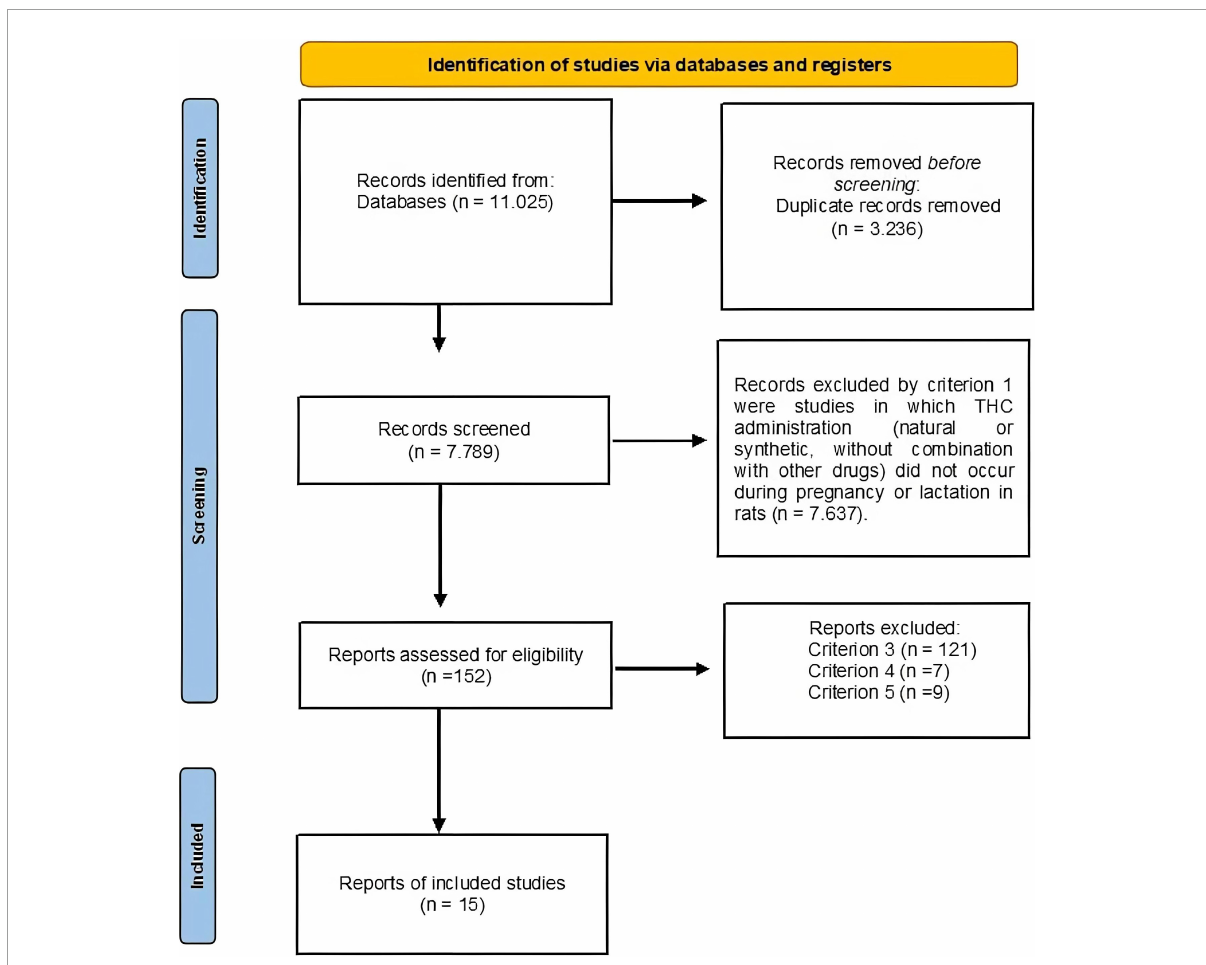
FIGURE1 Flowchart for the search of articles and its selection. The boxes in the left columns indicate the number of articles selected. Each arrow indicates the detection procedure. The boxes in the right column show the number of articles excluded due to each eligibility criteria.